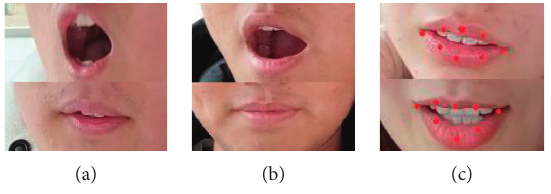
Figure 8: Comparison of mouth